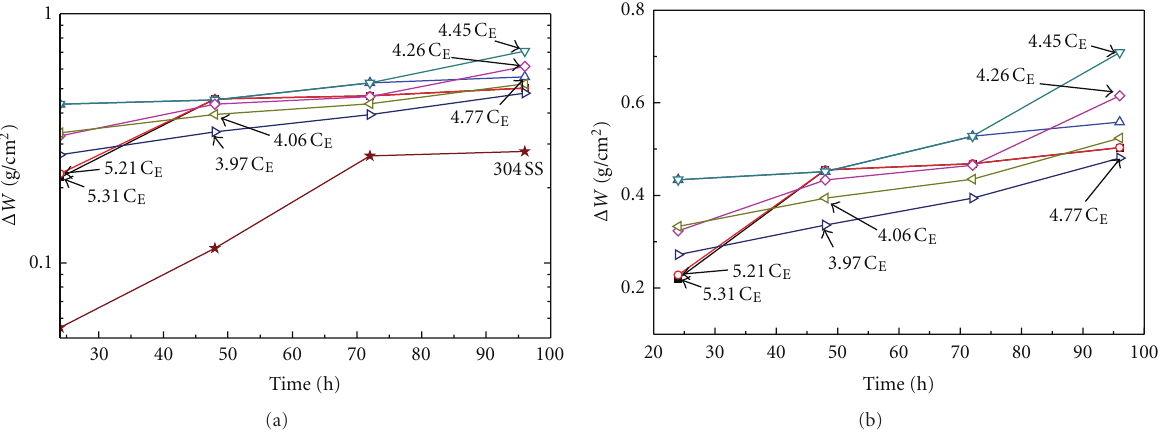
Figure 2: (a) Change in the weight loss with time for the di ff erent high-chromium, high-carbon cast irons in NaCl-KCl at 670 ◦ C, and (b) expanded plot of